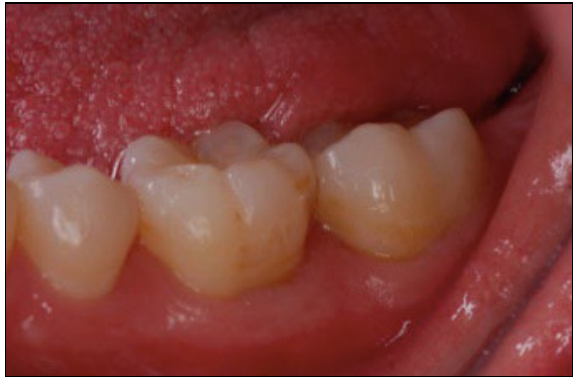
Figure 3. Biopsy site at four months follow-up. Healing at the site of concern seemed to occur